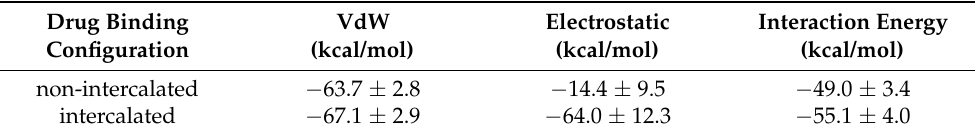
Table 1. Results of the MM/GBSA analyses of the MD trajectories of the htopIB-DNA complex with the drug in non-intercalated (Figure 5A) or intercalated (Figure 5C) configuration.